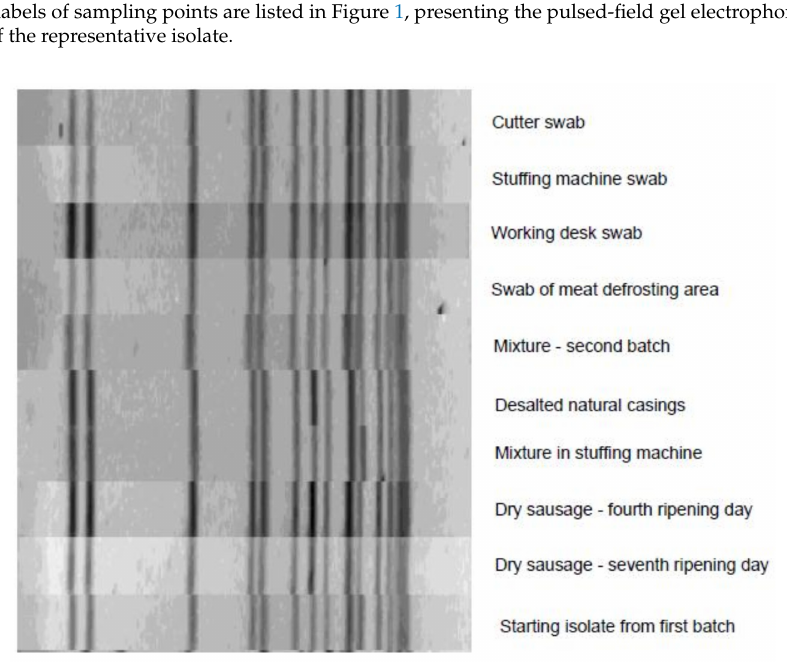
Figure 1. PFGE with ApaI enzyme images of the strains; dendrogram obtained using FPQUest (Biorad) software and Unweighted Pair Group Method with Arithmetic Mean (UPGMA), Dice (Opt: 0.50%) (Tol: 1.5–1.5%) (H > 0.0%; S > 0.0%)